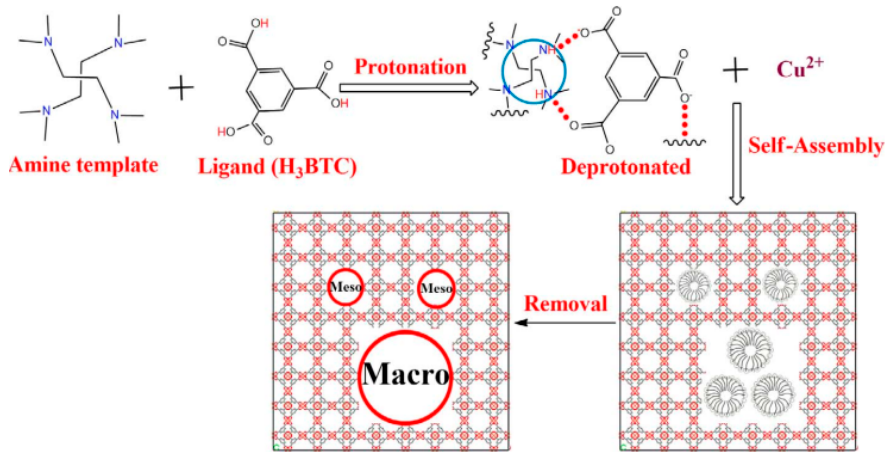
Figure 1. Possible mechanism for the synthesis of hierarchical porous MOFs using amine templates. Reprinted with permission from [39] Copyright (2018) Elsevier.